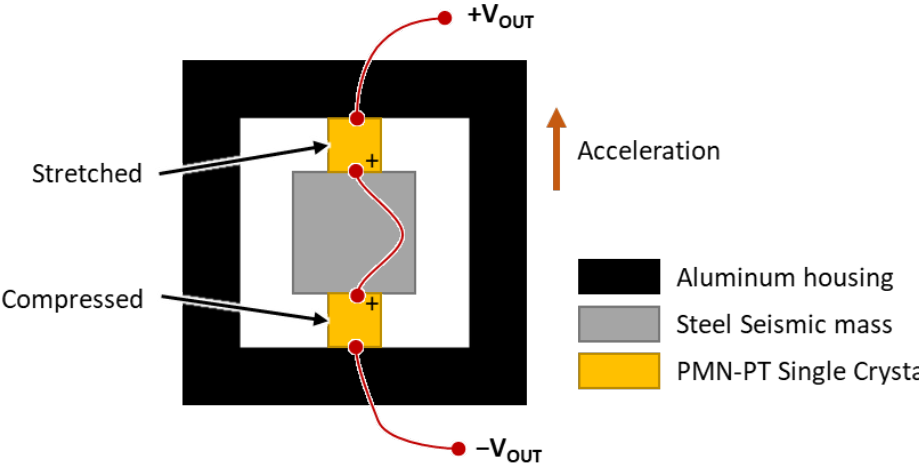
Figure 4. Operating principle of a compressive-type piezoelectric accelerometer with a pair of PMN- PT single crystals (other axes are omitted for clarity). The plus symbol on a single crystal indicates positive voltage output under compression.